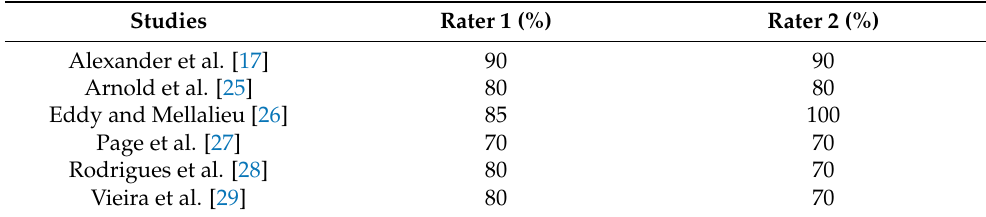
Figure 1. Flowchart of the systematic review process according to the PRISMA protocol declarations. Table 1. Quality assessment of qualitative studies.